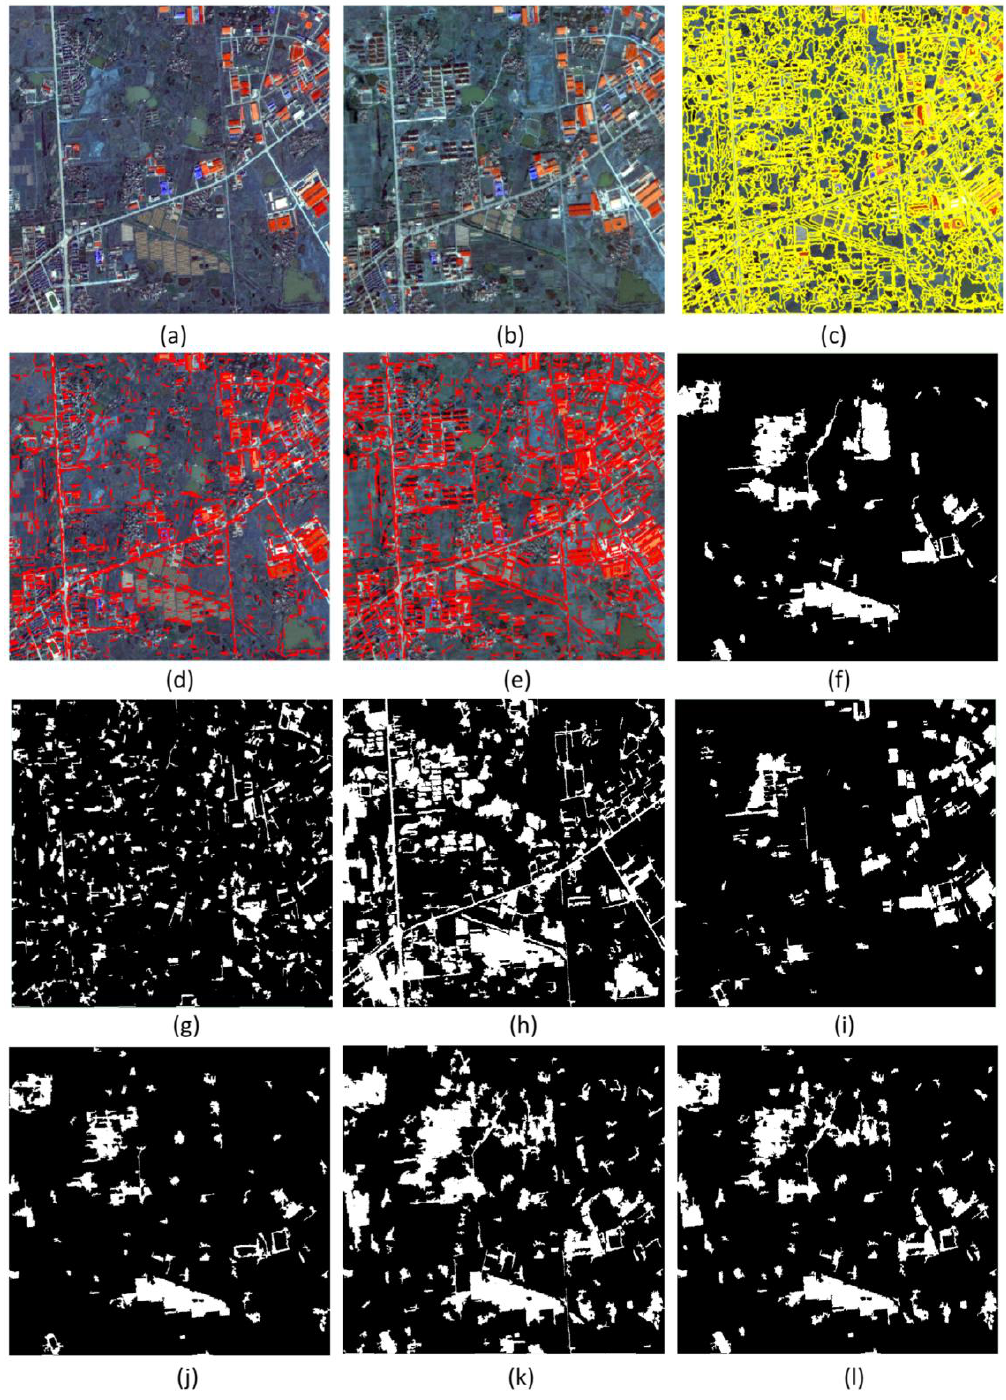
Figure 6. Experimental area 2. ( a , b ) Original bitemporal images. ( c ) TRPs. ( d , e ) TLPs. ( f ) Visual interpretation result. ( g ) Result of CVA. ( h ) Result of PCA-k-means. ( i ) Result of IRMAD. ( j ) Result of initial detection. ( k ) Result of direct threshold relaxation. ( l ) Result after